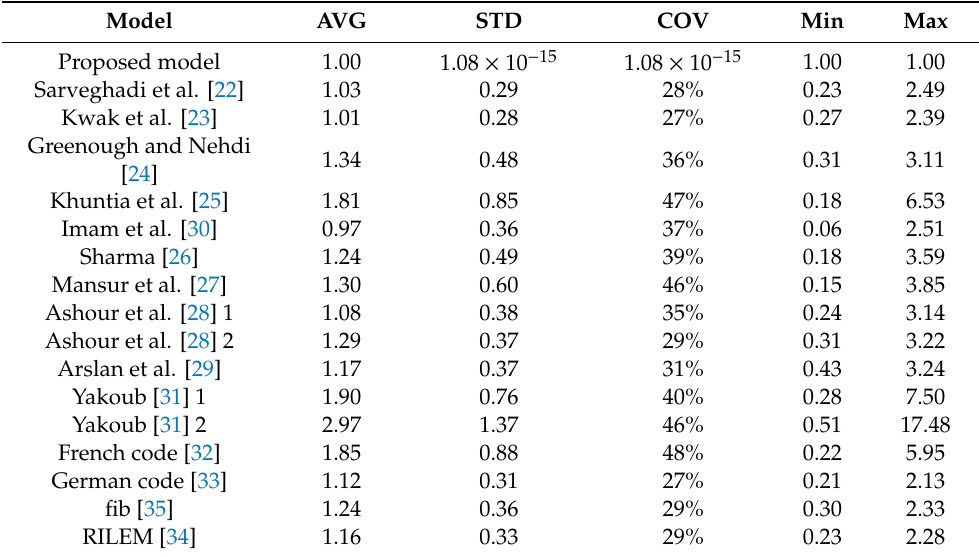
Table 8. Statistical properties of V utot / V pred for all datapoints, with AVG = average of V utot / V pred , STD = standard deviation on V utot / V pred , and COV = coe ffi cient of variation of V utot / V pred . This table repeats results from [114] for comparison to our proposed